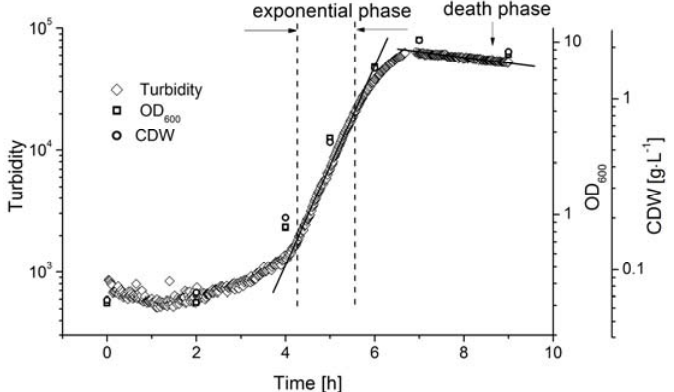
Figure 4. Online monitoring of biomass during the batch fermentation of B. coagulans for the production of LA, using optical density (OD 600 ) and cell dry weight (CDW) as reference methods. The values of OD 600 and CDW were determined three times.